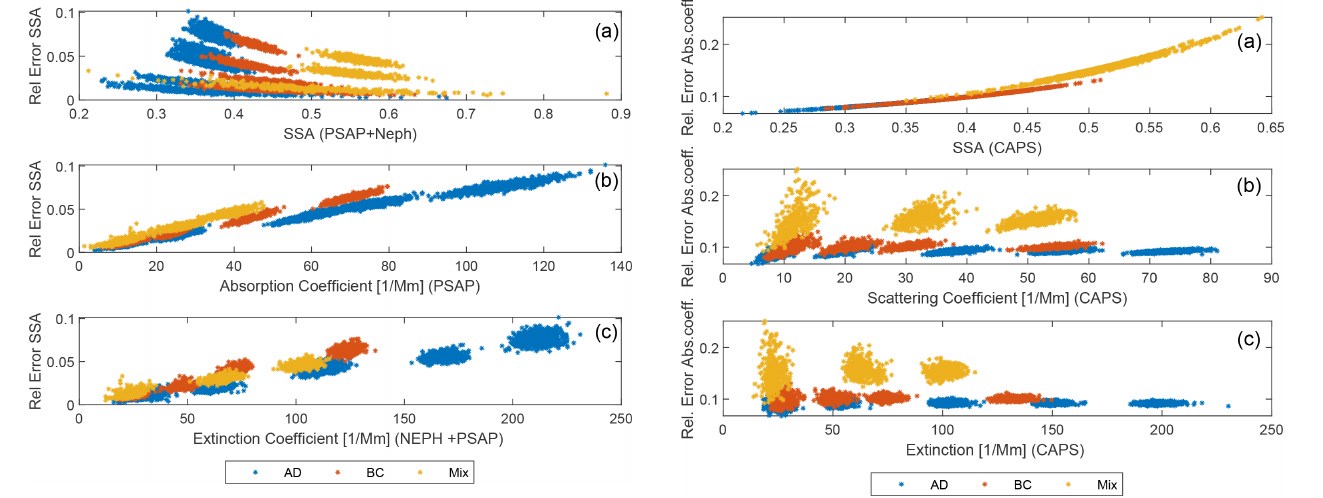
Figure A3. Relative error in the absorption coefficients using CAPS measurements as a function of SSA (a) , scattering coefficient (b) and extinction coefficient (c)